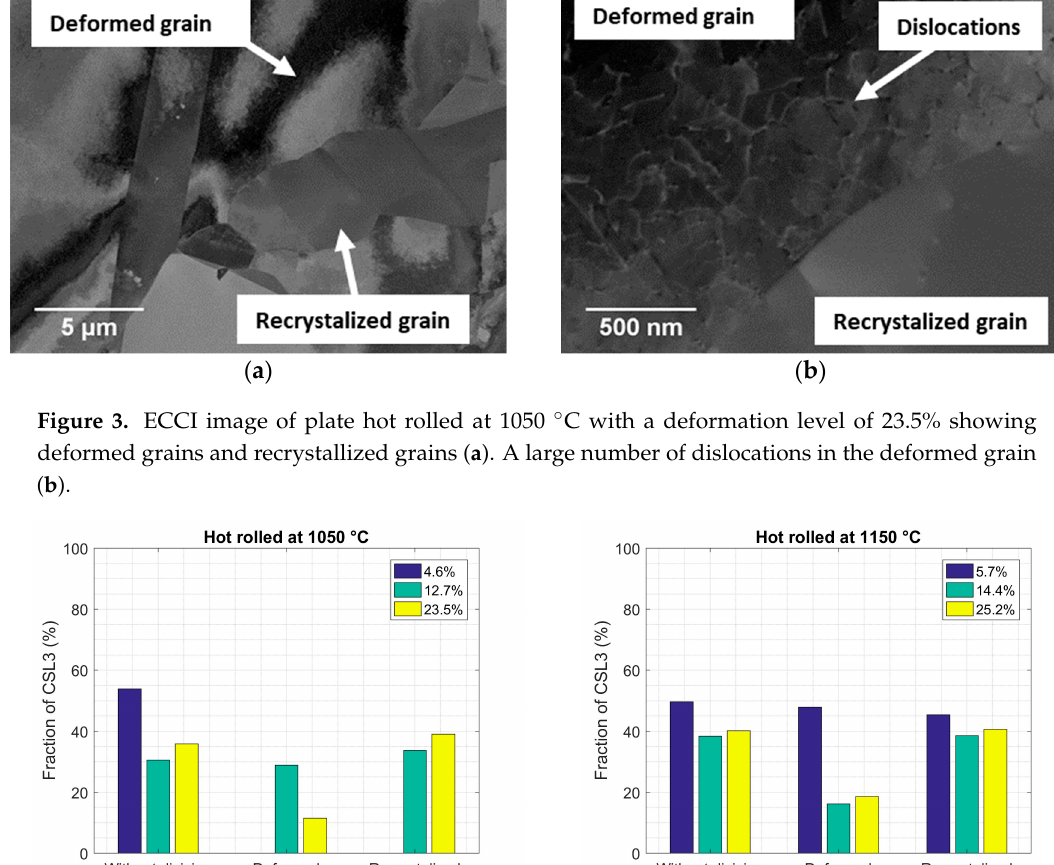
Figure 3. ECCI image of plate hot rolled at 1050 °C with a deformation level of 23.5% showing deformed grains and recrystallized grains ( a ). A large number of dislocations in the deformed grain ( b ).